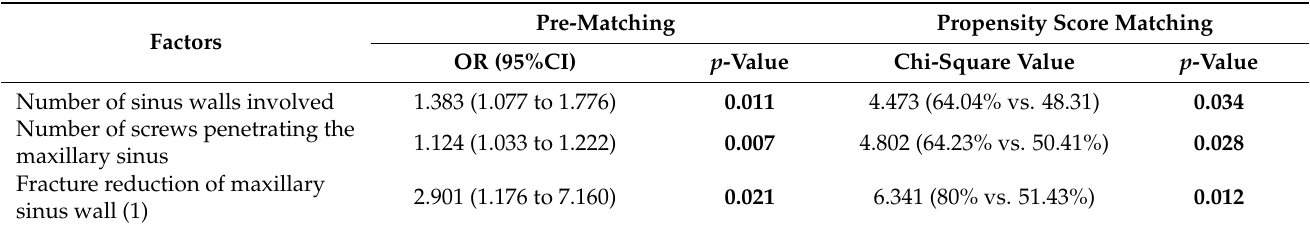
Table 5. Evaluation of risk factors for post-traumatic maxillary sinus pathology before and after